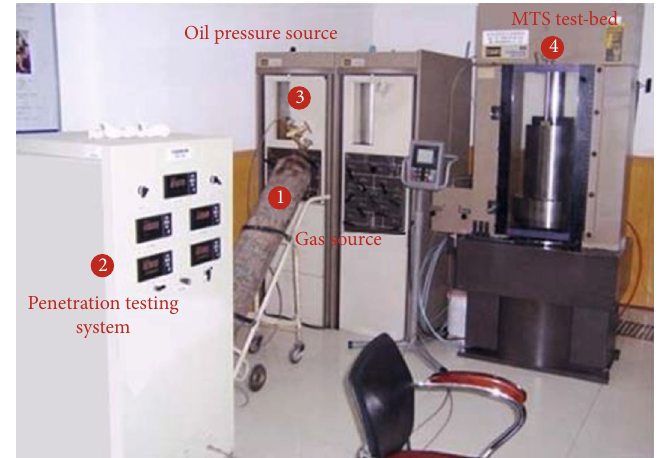
Figure 3: Rock gas permeability testing